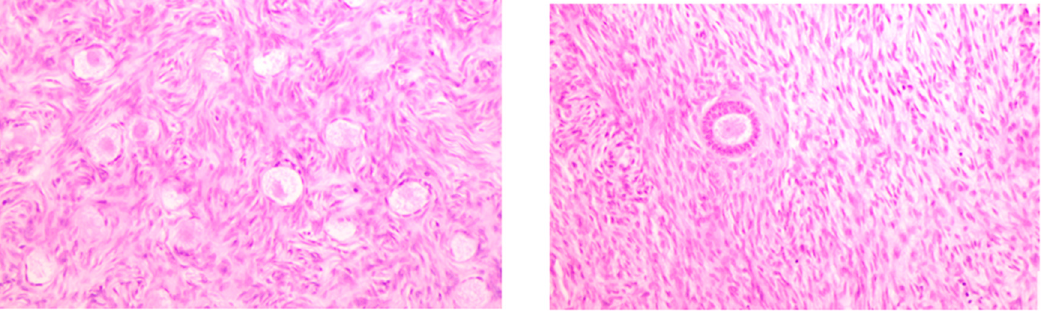
Figure 2. Different classes of counted follicles on ovarian tissue specimens. Observed in optical microscope Nicon Eclipse 50i with magnification × 20 HPF (High-power field).